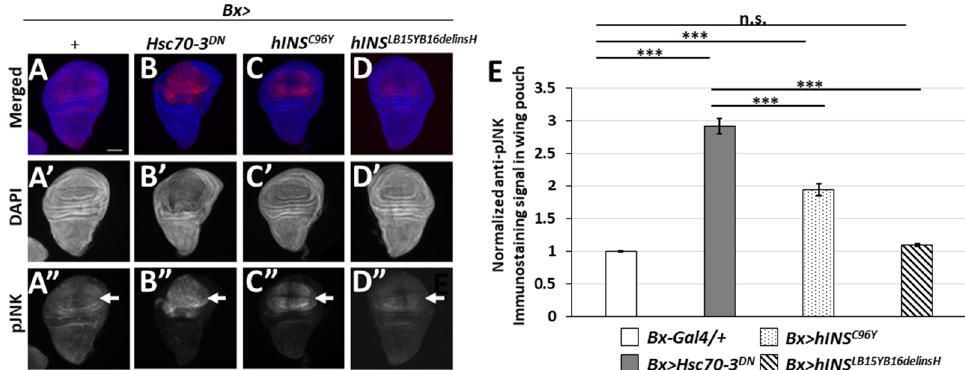
Figure 6. The ectopic expression of hINS C96Y can activate JNK pathway in wing imaginal discs. ( A – D ) Anti-pJNK immunostaining of wing imaginal discs having an accumulation of ER stress in third-instar larvae. ( A – A” ) A control wing disc ( Bx-Gal4/+ ). ( B – B ”) A wing discs expressing Hsc70-3 DN ( Bx > Hsc70-3 DN ). ( C – C” ) A wing disc expressing hINS C96Y ( Bx > hINS C96Y ). ( D – D ”) A wing disc expressing hINS LB15YB16delinsH ( Bx > hINS LB15YB16delinsH ). Anti-pJNK immunostaining signal and DNA staining are colored in red (white in ( A” – D” )) and blue (white in ( A’ – D’ )), respectively. Scale bar: 100 µ m. ( E ) Quantification of pJNK signals in wing imaginal discs. The intensity of anti-pJNK immunofluorescence was calculated and normalized to the control value, which was set as 1.0 ( Bx-Gal4/+ ) ( n > 15, *** p < 0.001, n.s.: not significant, Student’s t -test) Error bars represent SEMs.